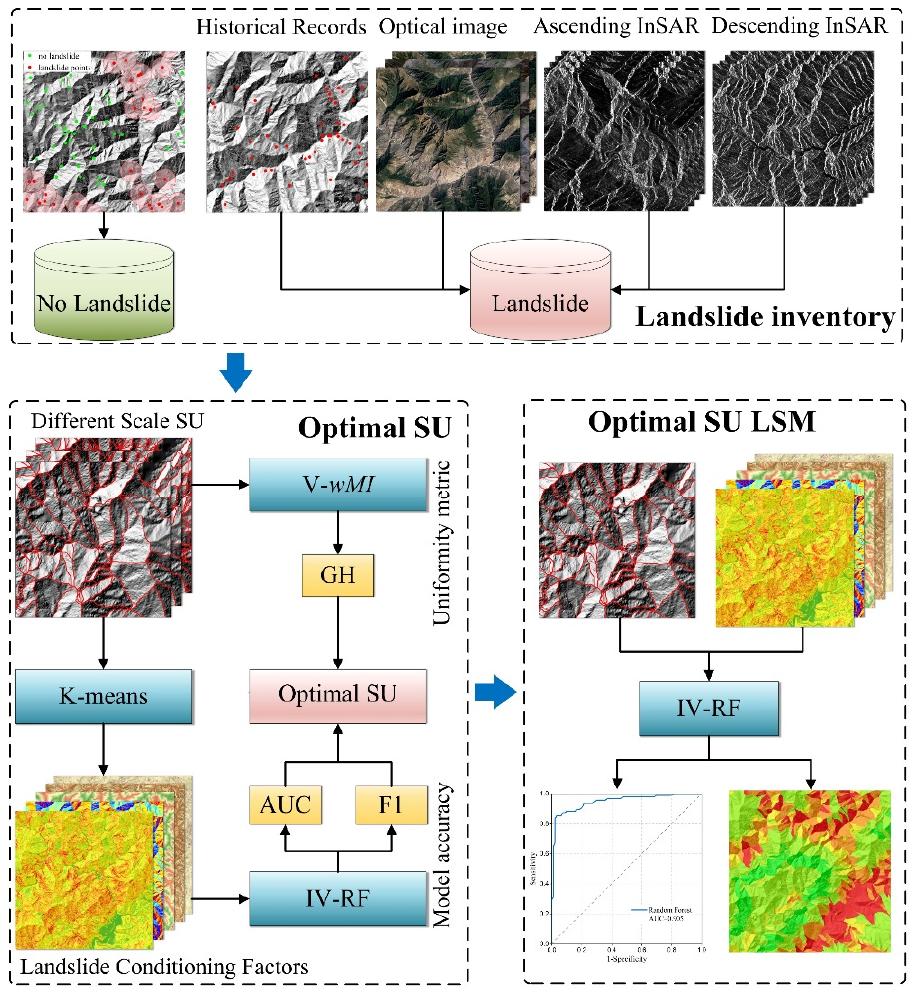
Figure 5. Flow chart of the proposed method in this study.